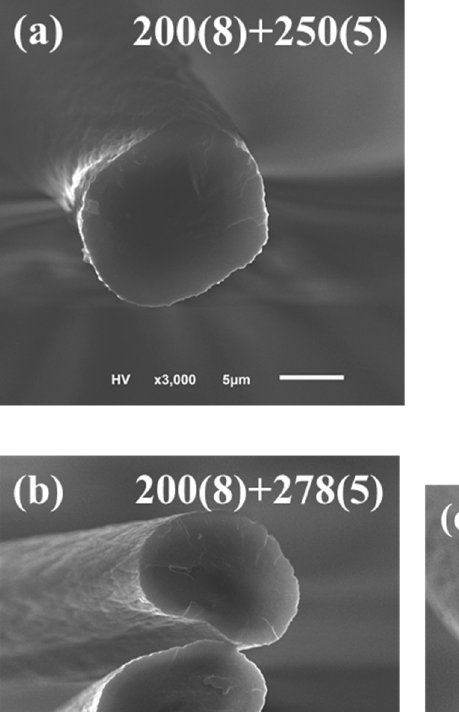
Figure 7. The XRD results of specimens under several two-step processing conditions. Table 1. The aromatic index of specimens under several processing conditions from XRD results. Specimens